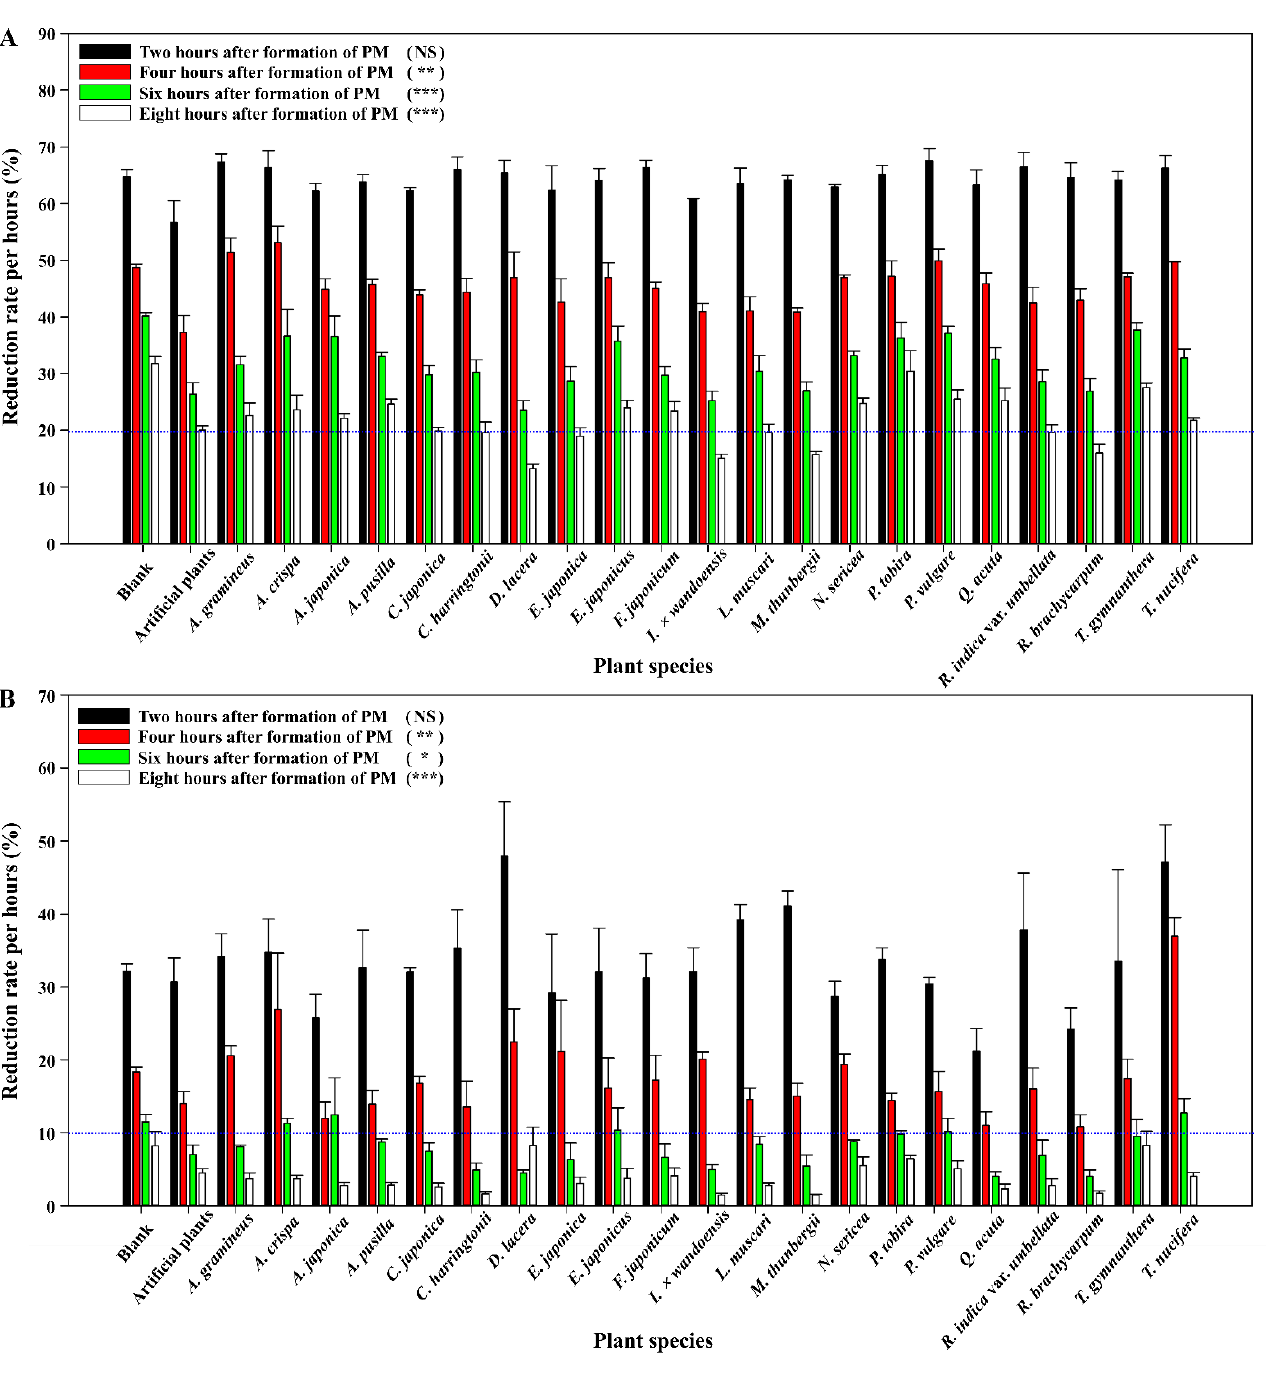
Figure 2. Reduction effect of plant species on mass concentration of ( A ) PM 2.5 and ( B ) PM 10 . Vertical bars represent mean ± SE ( n = 3). Reduction of particle matter (PM) mass concentration by plant species was analyzed using a one-way ANOVA. NS, not significant; *, **, and ***, significance at p < 0.05, 0.01, and 0.001, respectively.